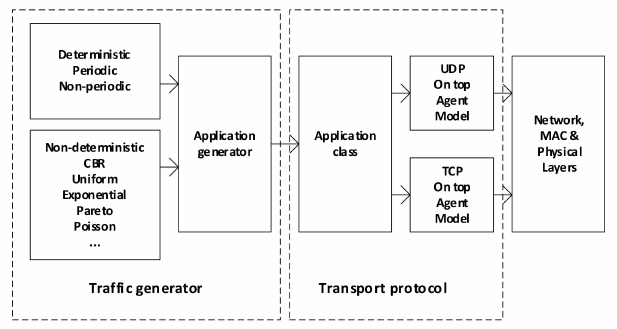
Figure 5. Node model with traffic generator.